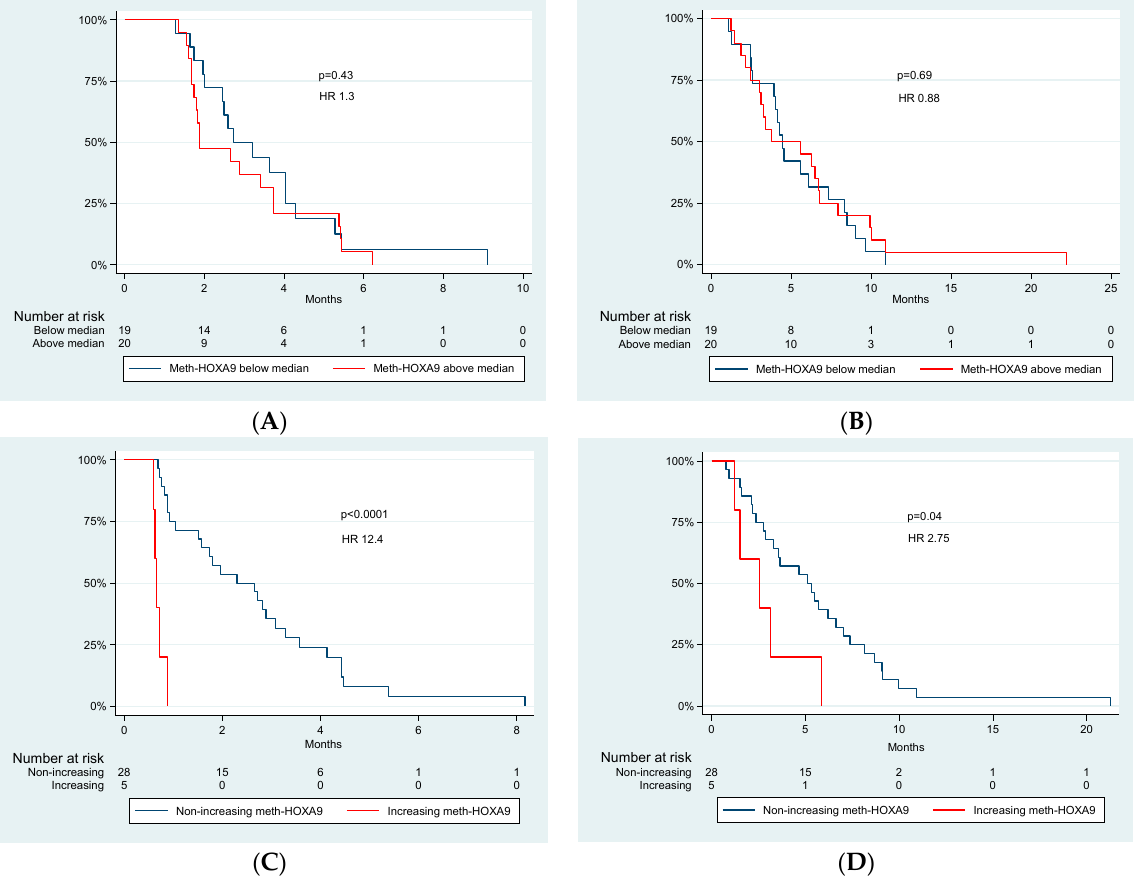
Figure 1. Kaplan-Meier plots for meth-HOXA9 below median vs. meth-HOXA9 above median at baseline (( A ) PFS at baseline, ( B ) OS at baseline) and non-increasing meth-HOXA9 vs. increasing meth-HOXA9 after one treatment cycle (( C ) PFS after one treatment cycle, ( D ) OS after one treatment cycle). p -values and hazard ratios (HR) are shown.